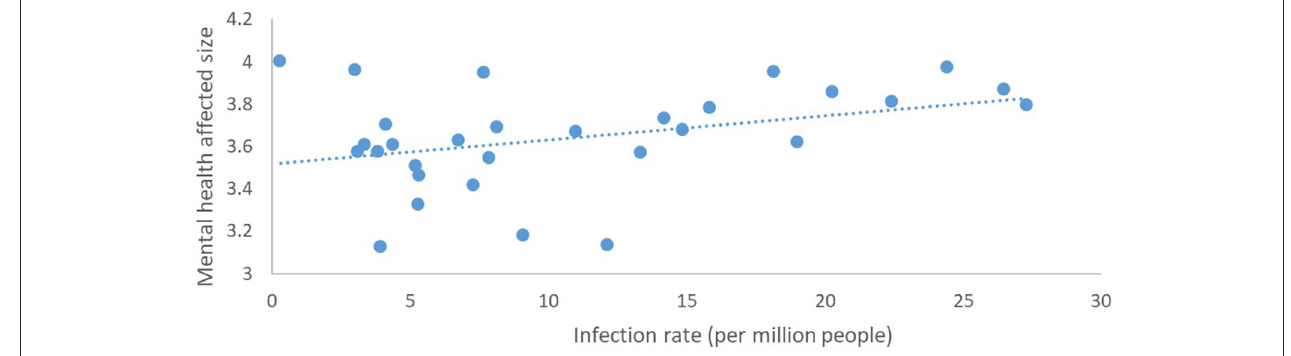
FIGURE 3 | The relationship between the degree of mental health impact and provincial proportions of confirmed COVID-19 cases.